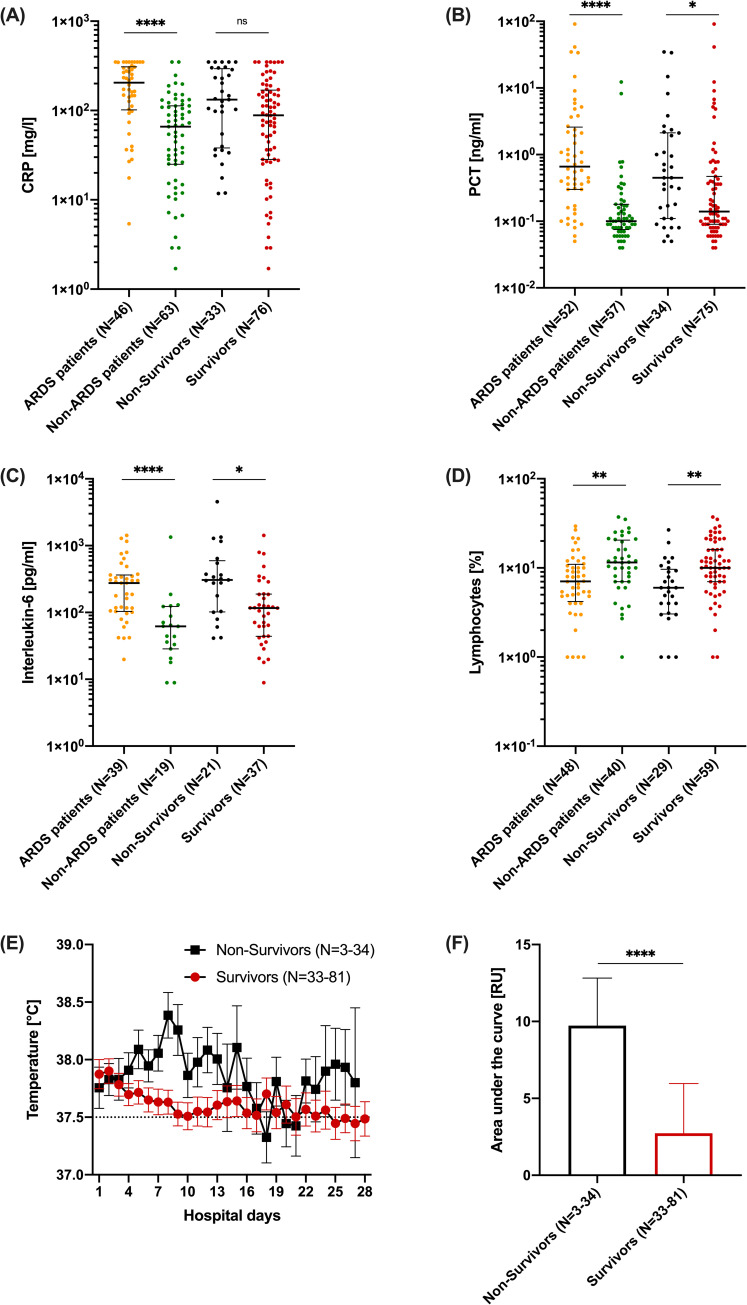
Inflammatory burden compared in the different subgroups.(A) CRP (C reactive protein) in mg/l for each individual with Median [IQR25; IQR75] of ARDS patients vs. Non-ARDS patients (orange, 205.3 [101.7; 309.0], N = 46 vs. green, 65.9 [25.0; 113.0], N = 63), Non-Survivors vs. Survivors (black, 132.6 [38.0; 293.5], N = 33 vs. red, 88.4 [28.3; 168.9], N = 76). (B) PCT (Procalcitonin) in ng/ml for each individual with Median [IQR25; IQR75] of ARDS patients vs. Non-ARDS patients (orange, 0.66 [0.3; 2.6], N = 52 vs. green, 0.1 [0.07; 0.18], N = 57), Non-Survivors vs Survivors (black, 0.45 [0.11; 2.1], N = 34 vs. red, 0.14 [0.09; 0.47], N = 75). (C) Interleukin-6 in pg/ml for each individual with Median [IQR25; IQR75] of ARDS patients vs. Non-ARDS patients (orange, 275.8 [103.4; 364.5], N = 39 vs. green, 61.9 [28.5; 123.0], N = 19), Non-Survivors vs. Survivors (black, 306.8 [102.1; 594.6], N = 21 vs. red, 116.6 [43.9; 188.1], N = 37). (D) Lymphocytes in % for each individual with Median [IQR25; IQR75] of ARDS patients vs. Non-ARDS patients (orange, 7.0 [4.2; 10.9], N = 48 vs. green, 11.5 [7.0; 20.5], N = 40), Non-Survivors vs. Survivors (black, 6.0 [3.0; 9.6], N = 29 vs. red, 10.0 [7.0; 16.1], N = 59). (E) Mean temperature by hospital days of Non-Survivors (black, Mean ± SEM, N = 3–34) and Survivors (red, Mean ± SEM, N = 33–81). (F) Area under the temperature curve (see 1E) in relative arbitrary units with Mean ± SEM for Non-Survivors vs. Survivors (black, 9.7 ± 3.1, N = 3–34 vs. red, 2.7 ± 3.2, N = 33–81).